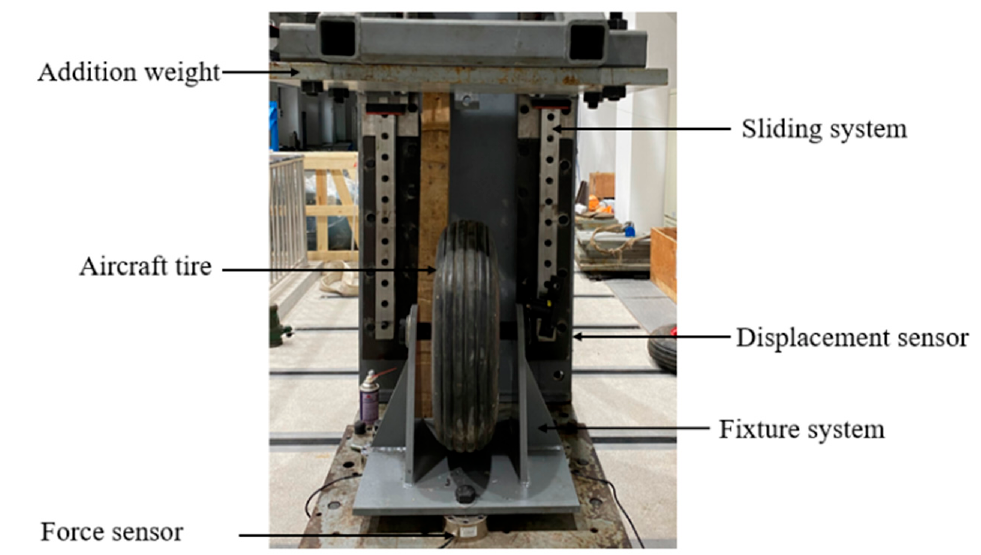
Figure 5. The aircraft tire experimental test.